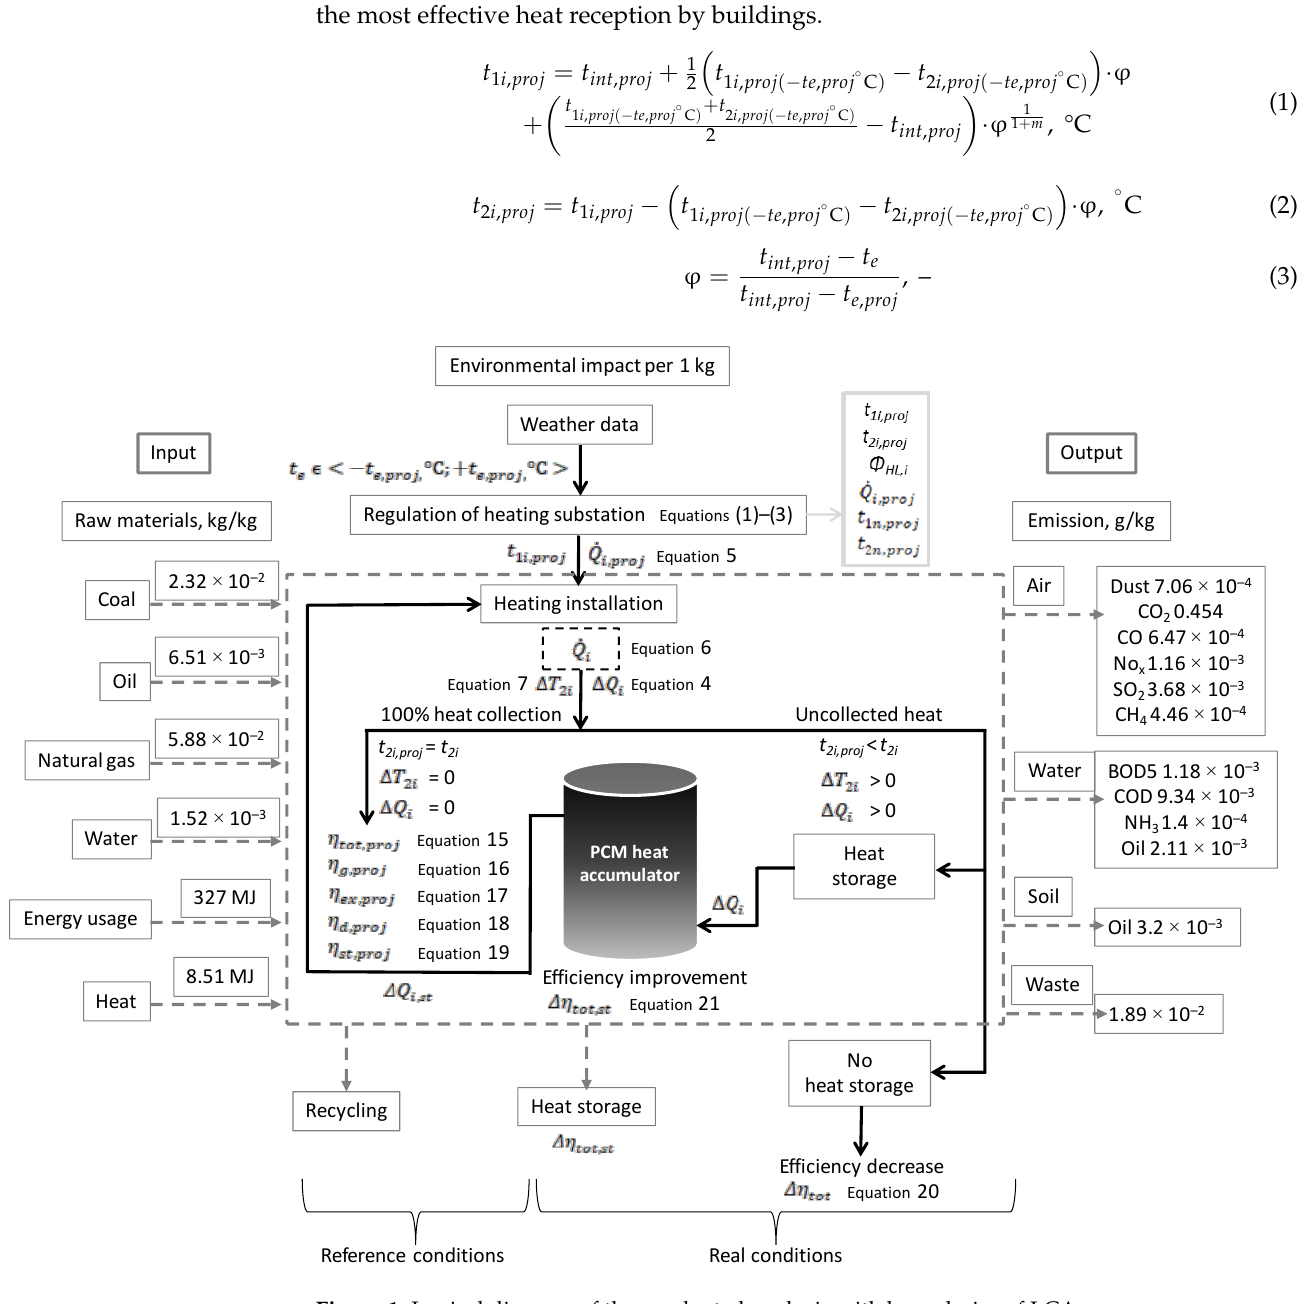
Figure 1 . Logical diagram of the conducted analysis with boundaries of LCA . Figure 1. Logical diagram of the conducted analysis with boundaries of